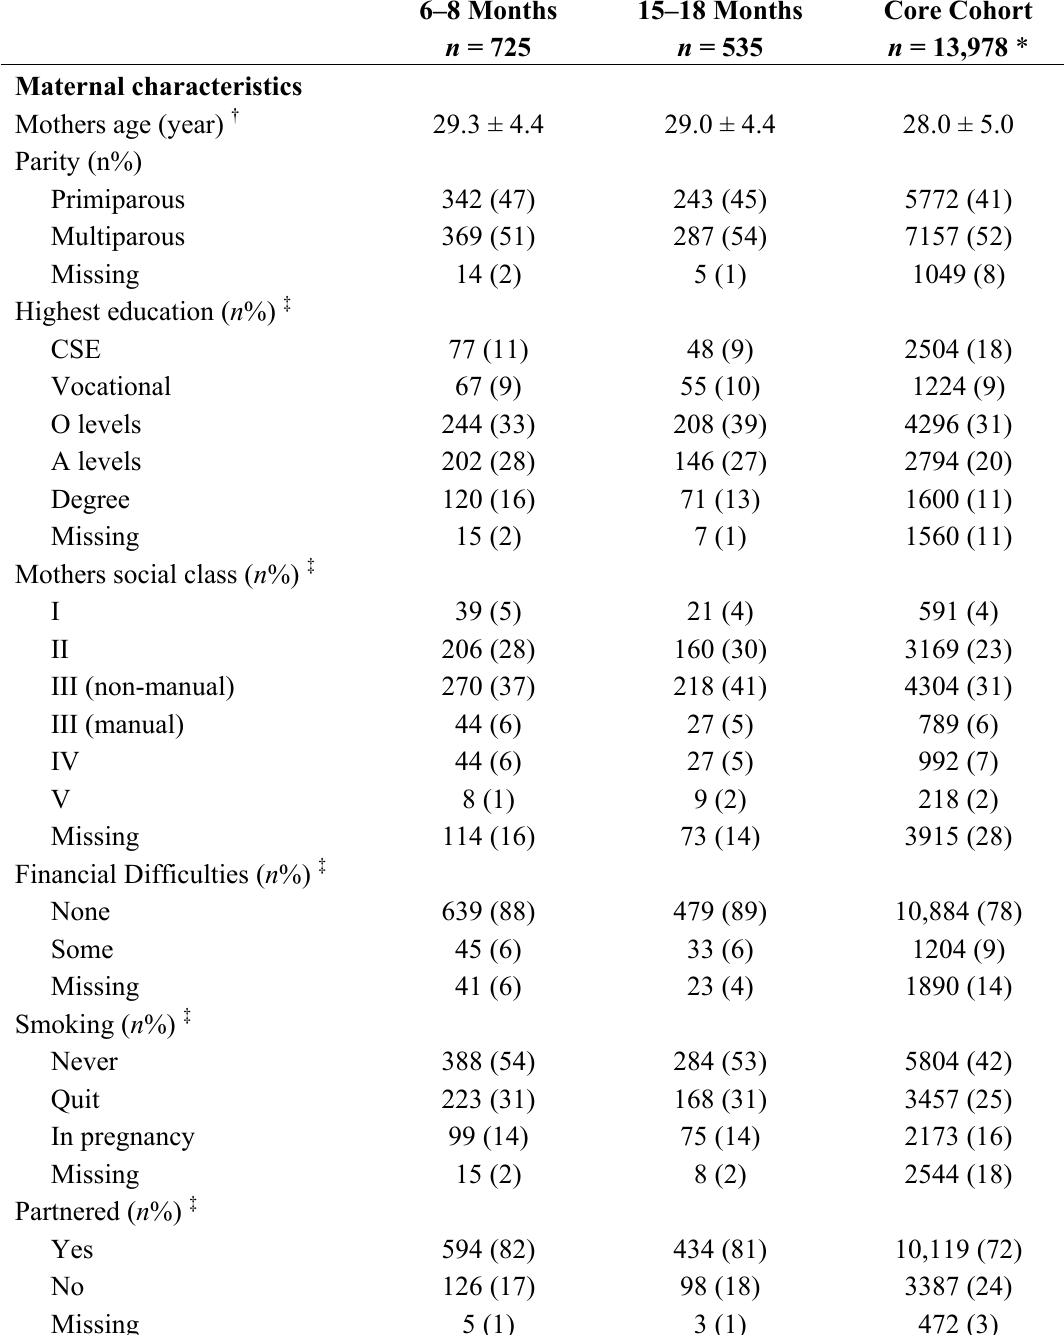
Table 1. Characteristics of the subset of the ALSPAC cohort included in the analysis of patterns and nutrients at 6–8 months or at 15–18 months of